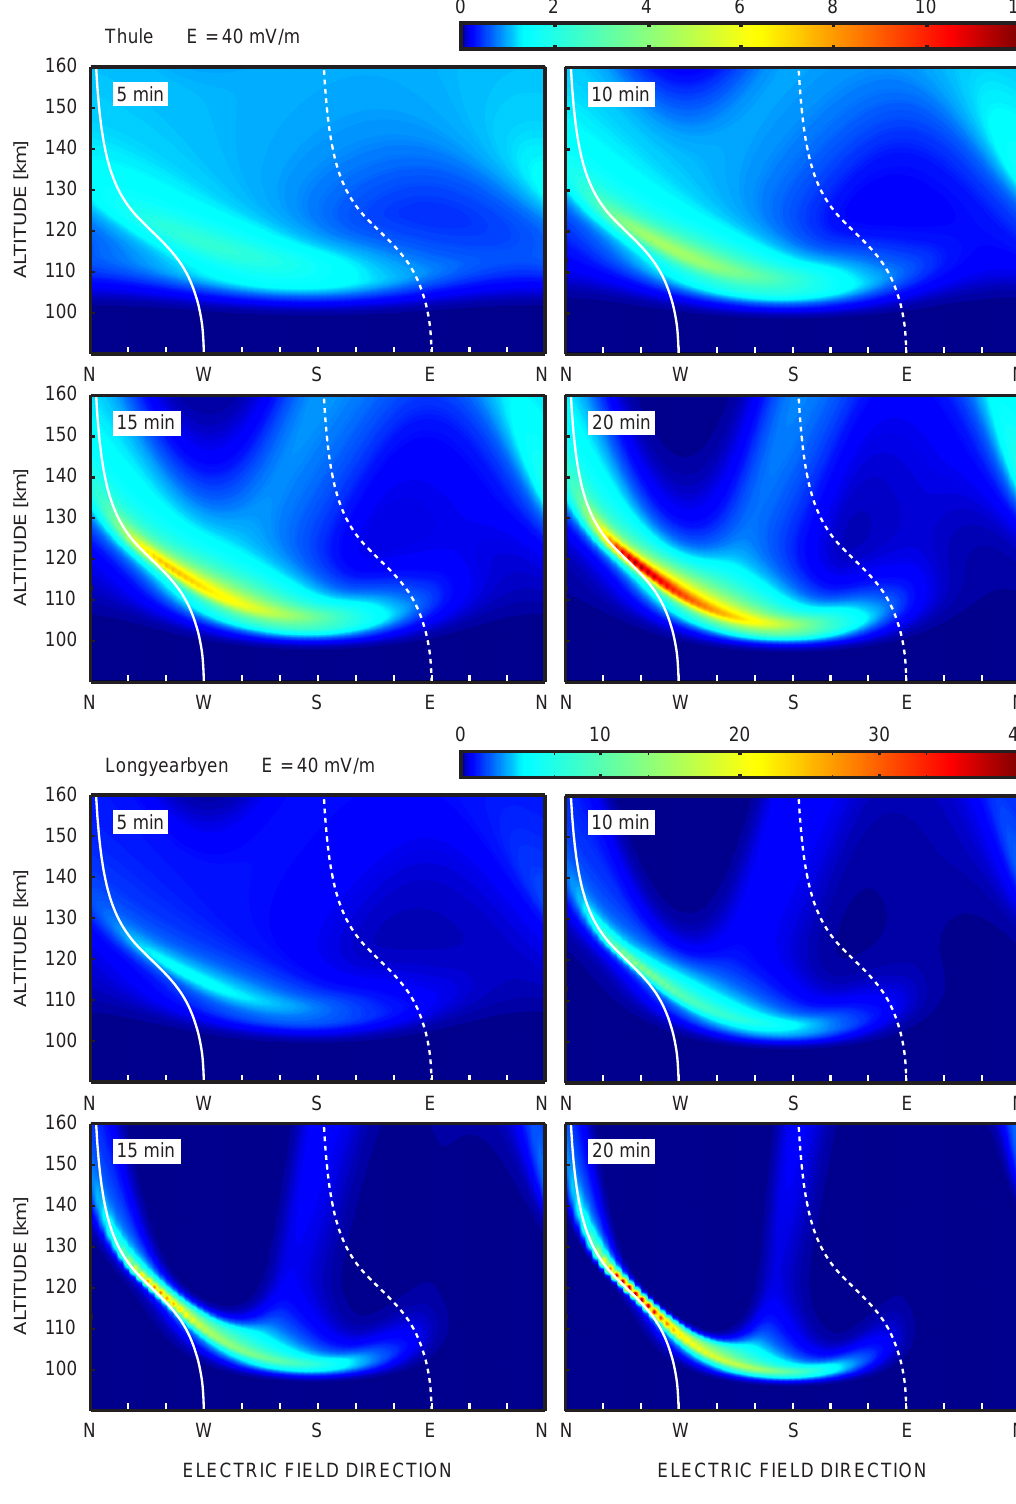
Fig. 3. Time development of Fe + layer generation for all electric field directions at Thule and Longyearbyen. The start ion density profile is the same as in Fig. 2. The colour bars indicate the scales of electron density. Convergent and divergent nulls are shown by the white continuous and dashed lines,